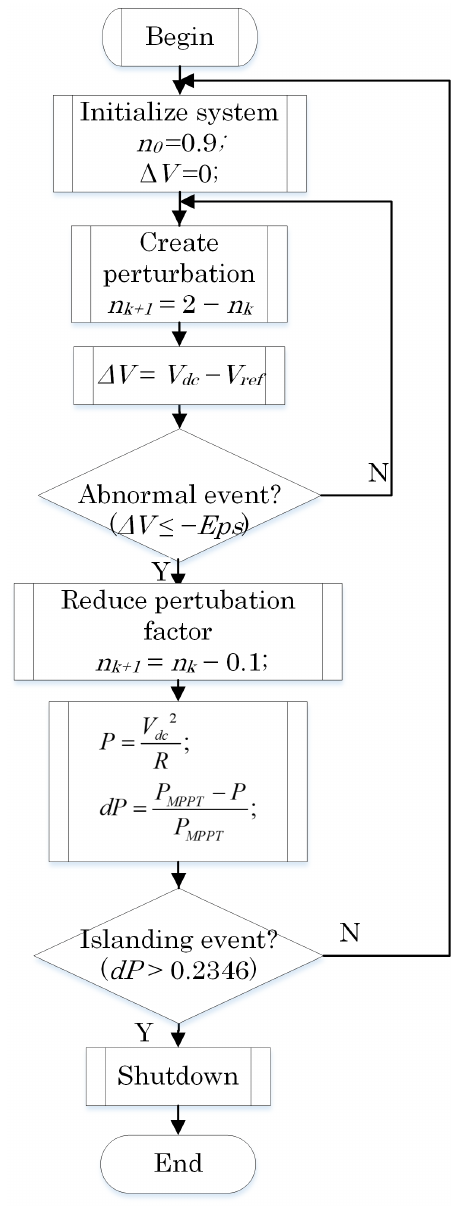
Figure 7. Flow chart of the IDM program ( n 0 is perturbation factor at the beginning, ∆ V is voltage deviation, Eps is abnormal event value, dP is the rate of change of output